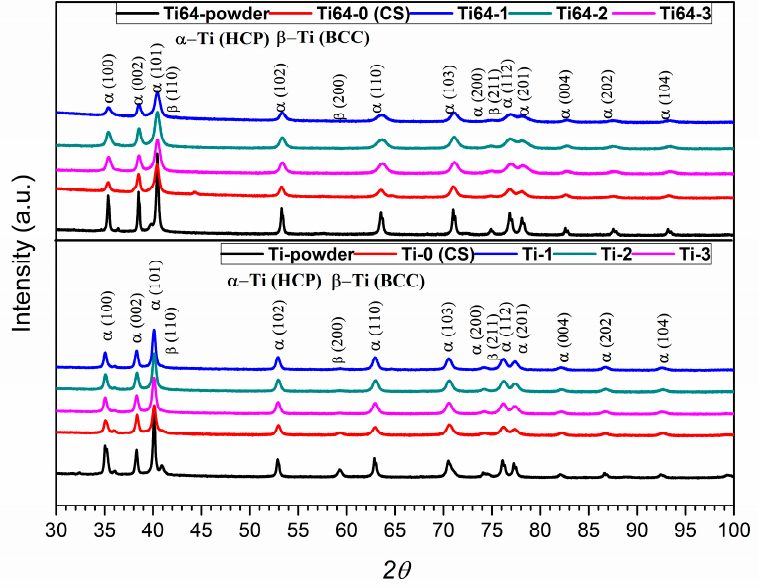
Figure 5. Set of diffraction patterns for Ti and Ti64 material for powders, cold-sprayed samples, and laser-treated